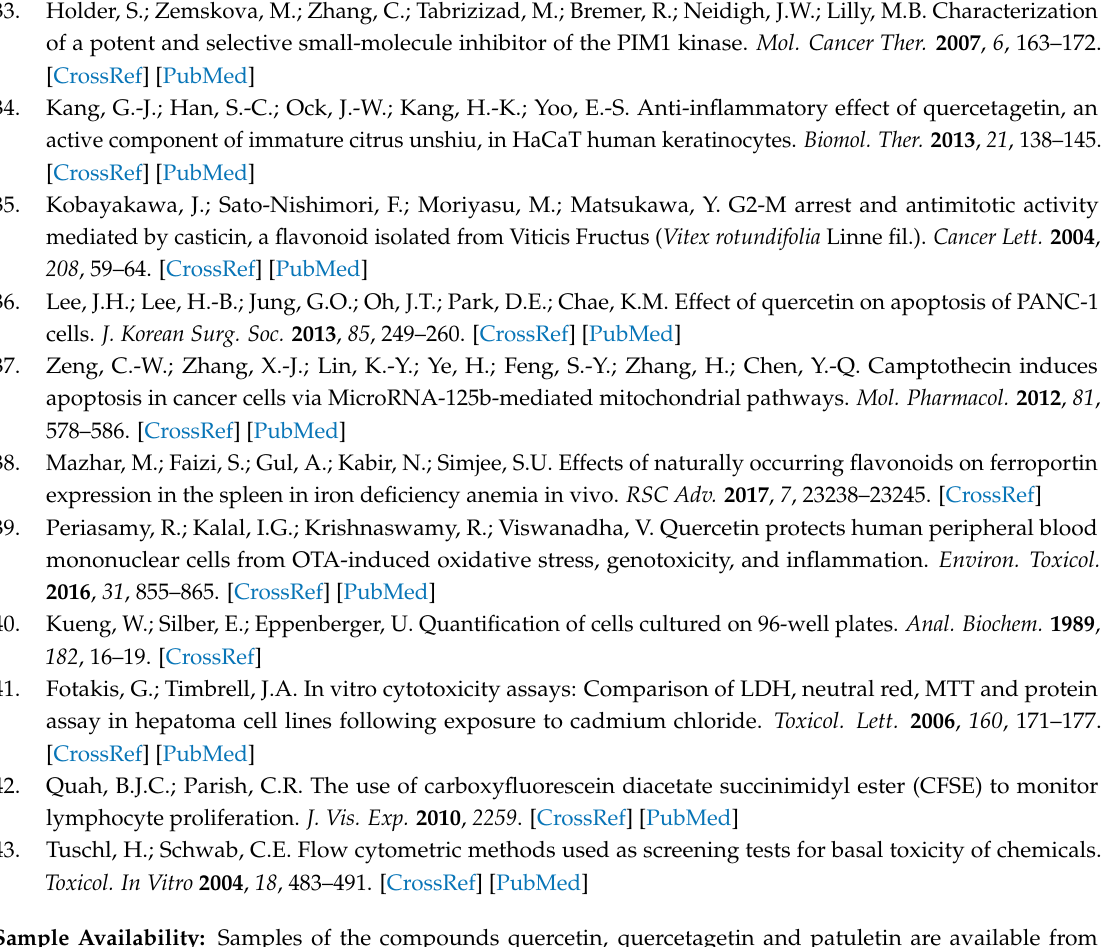
Sample Availability: Samples of the compounds quercetin, quercetagetin and patuletin are available from the